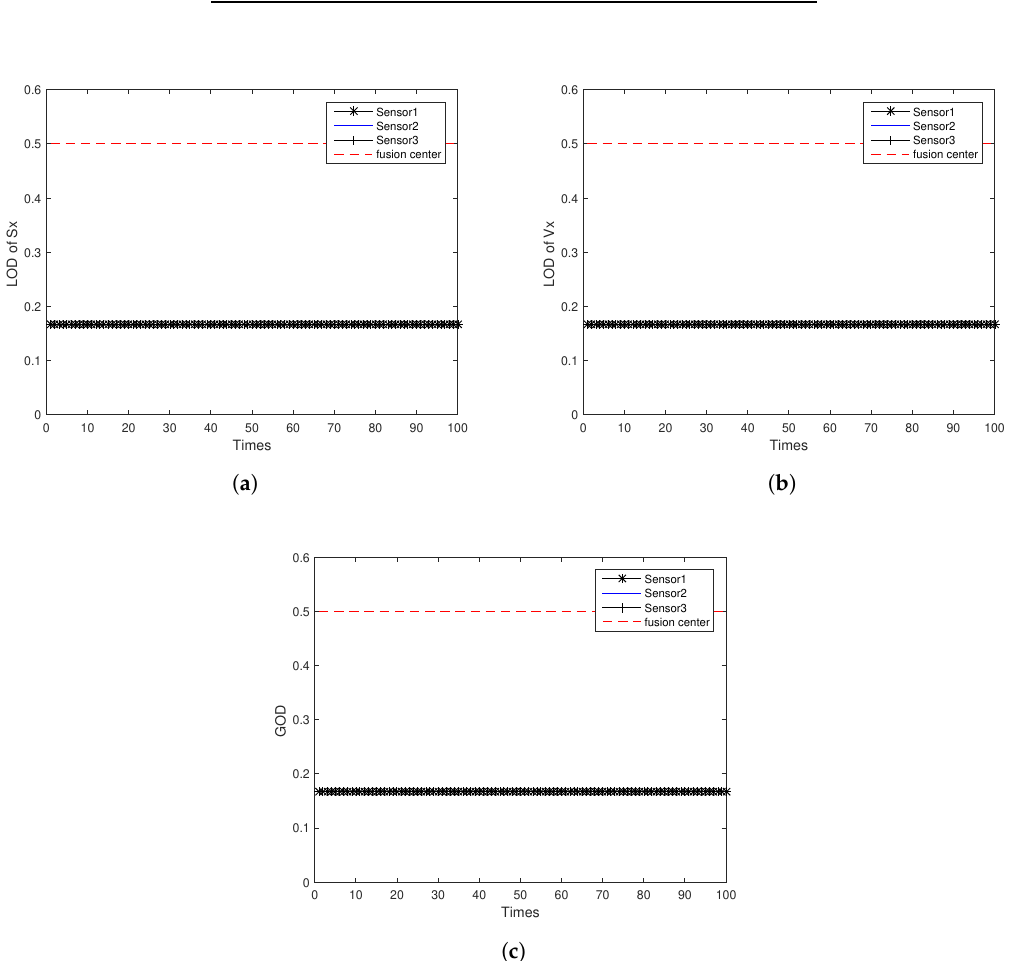
Figure 10. Observable degree of local filter and fusion center:( a ) LOD of Sx; ( b ) LOD of Vx; ( c )